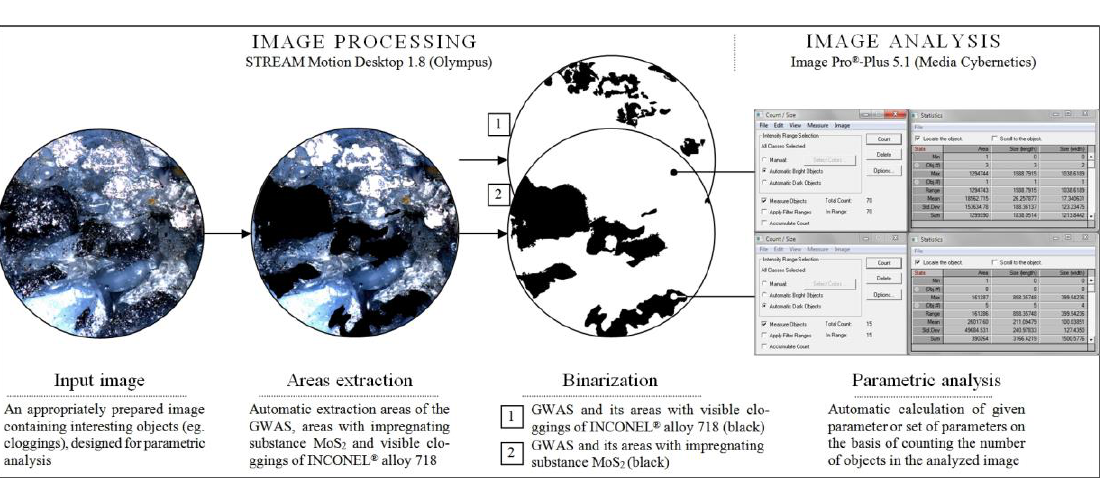
Figure 6. Procedure of image processing and analysis realized by Olympus STREAM Motion Desktop 1.8 and Media Cybernetics Image Pro ® -Plus 5.1 software in relation to images of the 1-35 × 10 × 10 × 109 A5X60L10VE01PI-50 GWAS acquired using a three-dimensional (3D) laser microscope Olympus LEXT OLS4000.